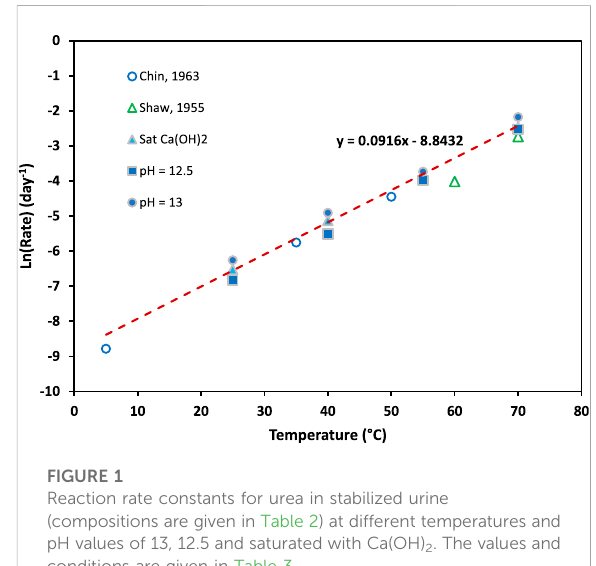
Reaction rate constants for urea in stabilized urine (compositions are given in Table 2) at different temperatures and pH values of 13, 12.5 and saturated with Ca(OH) 2 . The values and conditions are given in Table